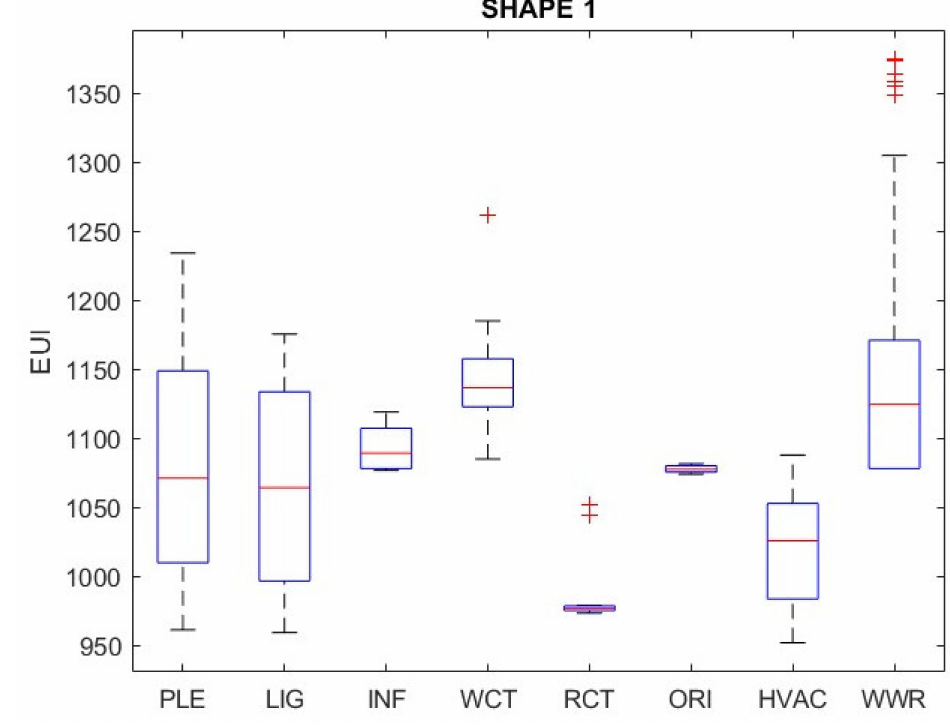
Figure 5. Boxplot of EUI vs. selected building